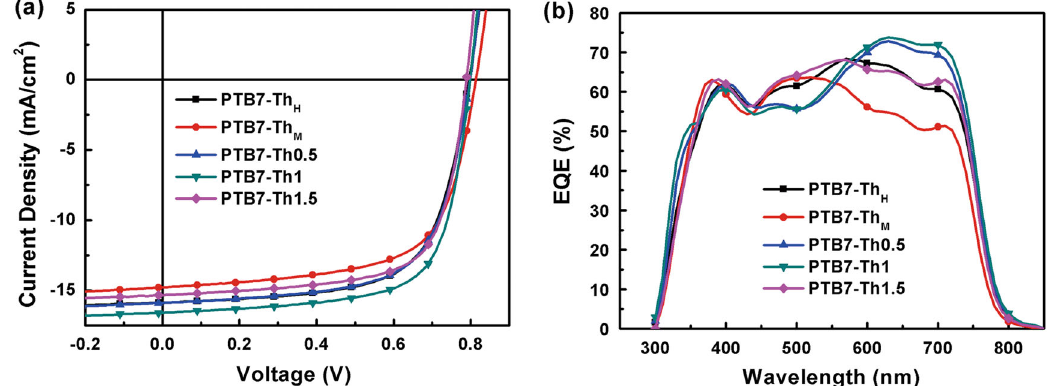
Fig. 2 a J – V and b EQE curves of photovoltaic devices with the con fi guration of ITO/PEDOT:PSS/donor polymer PTB7-Th and PTB7-ThIrx (0.5, 1, and 1.5):PC